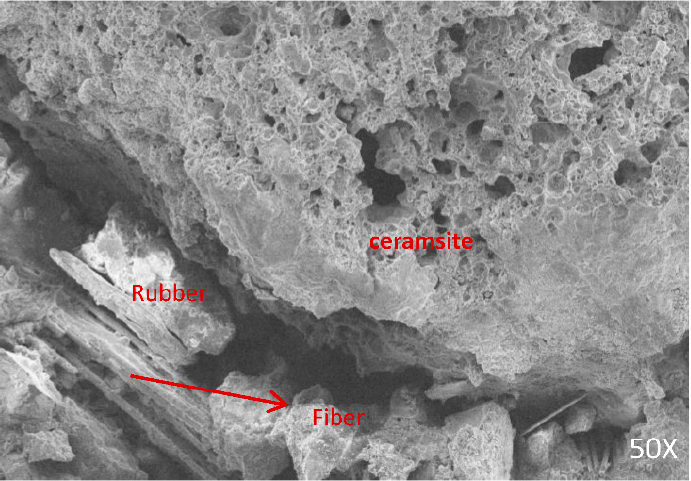
Figure 10. Microscopic diagram of rubber particles distributed in cracks.